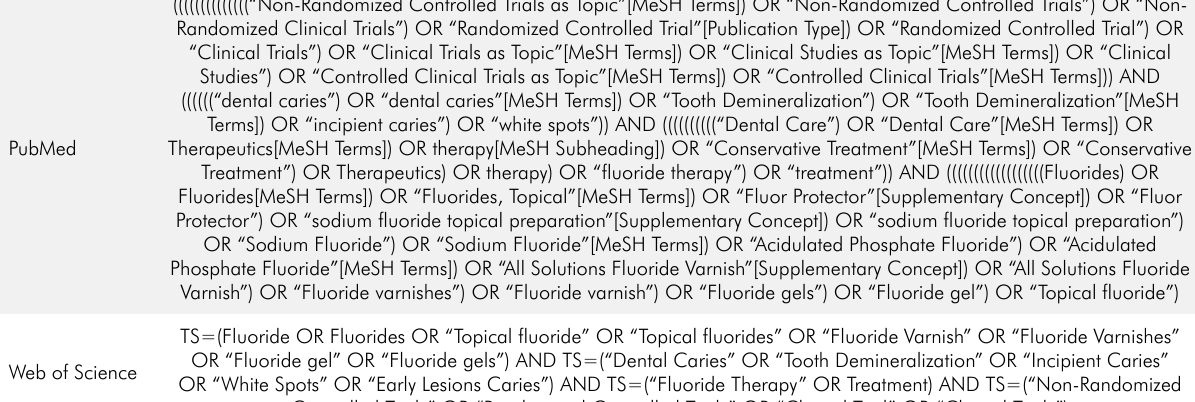
Table 1. Detailed search strategies used for specific databases. ((((((((((((((“Non-Randomized Controlled Trials as Topic”[MeSH Terms]) OR “Non-Randomized Controlled Trials”) OR “Non- Randomized Clinical Trials”) OR “Randomized Controlled Trial”[Publication Type]) OR “Randomized Controlled Trial”) OR “Clinical Trials”) OR “Clinical Trials as Topic”[MeSH Terms]) OR “Clinical Studies as Topic”[MeSH Terms]) OR “Clinical Studies”) OR “Controlled Clinical Trials as Topic”[MeSH Terms]) OR “Controlled Clinical Trials”[MeSH Terms])) PubMed